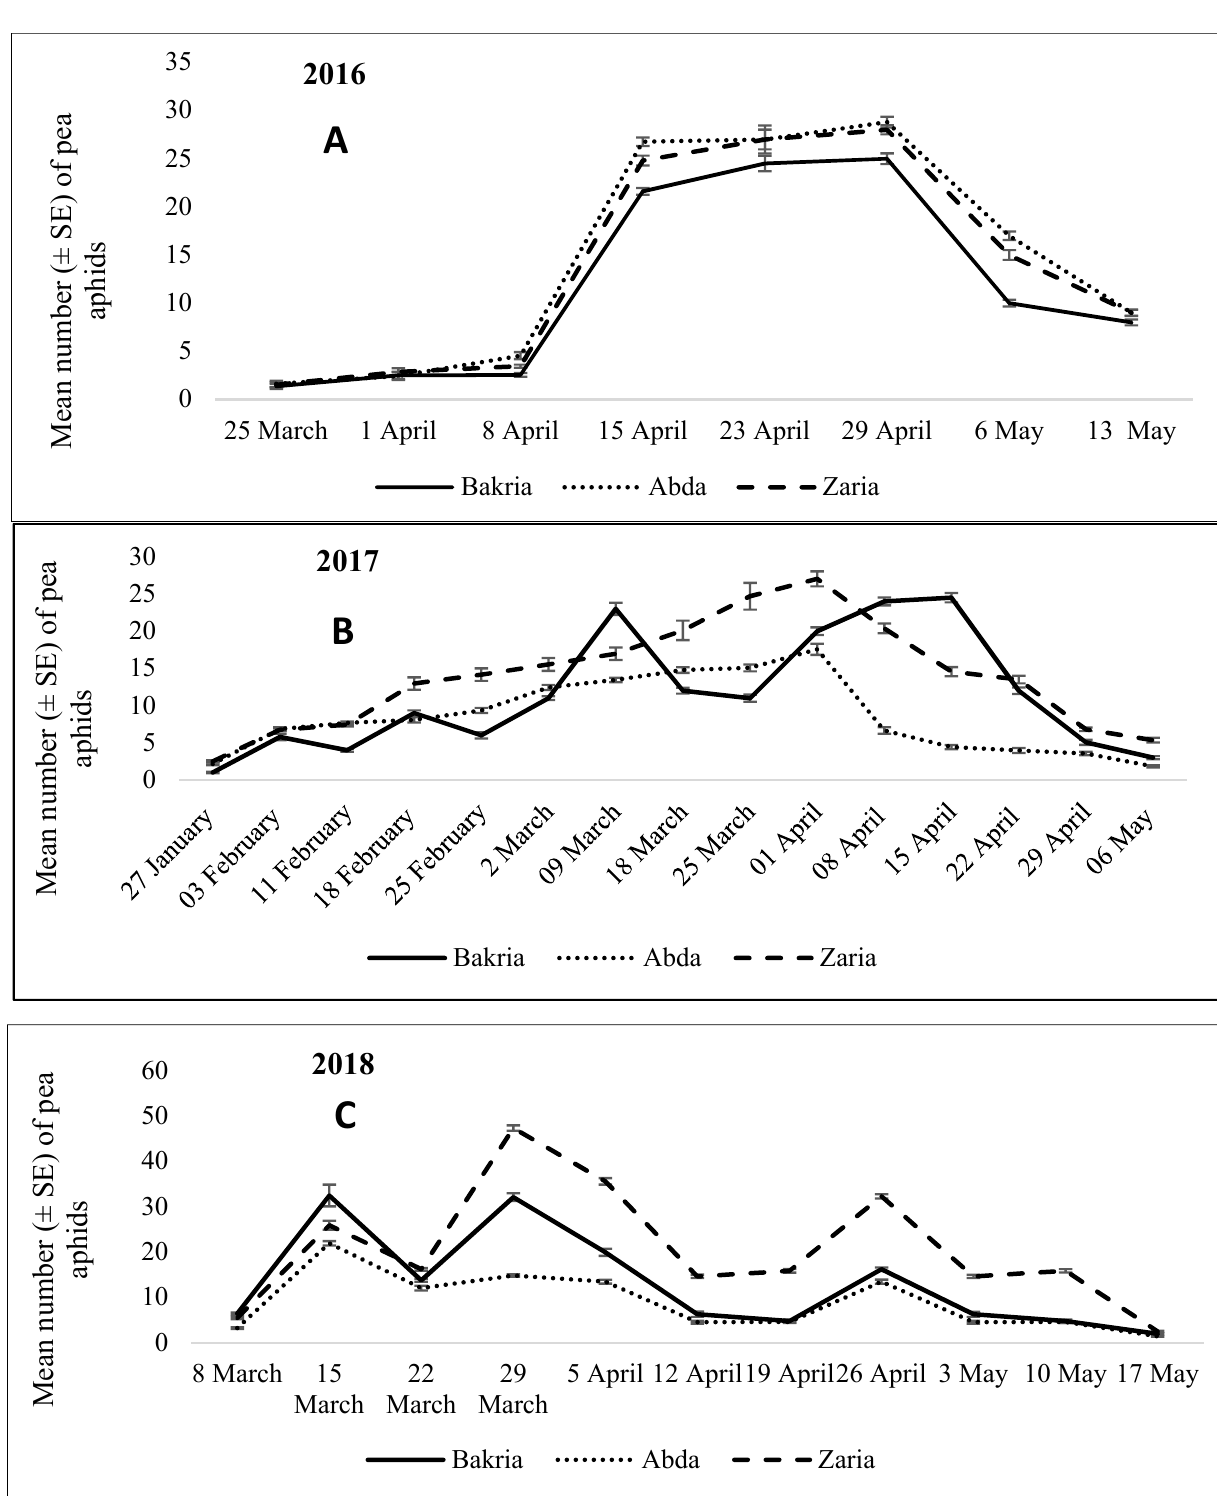
Figure 1. Population of pea aphids per 20 twigs for three lentil varieties during 2016 ( A ), 2017 ( B ), and 2018 ( C ) (means ± SE of 20 samples).